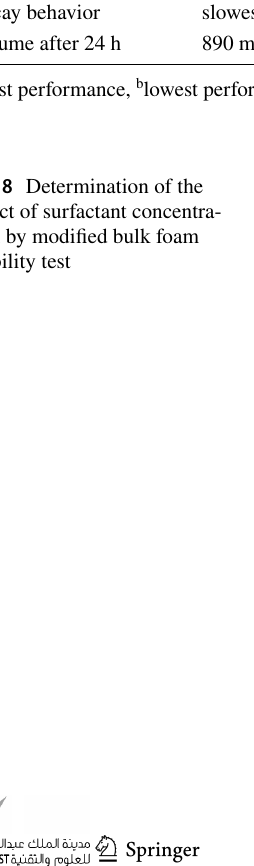
a Best performance, b lowest